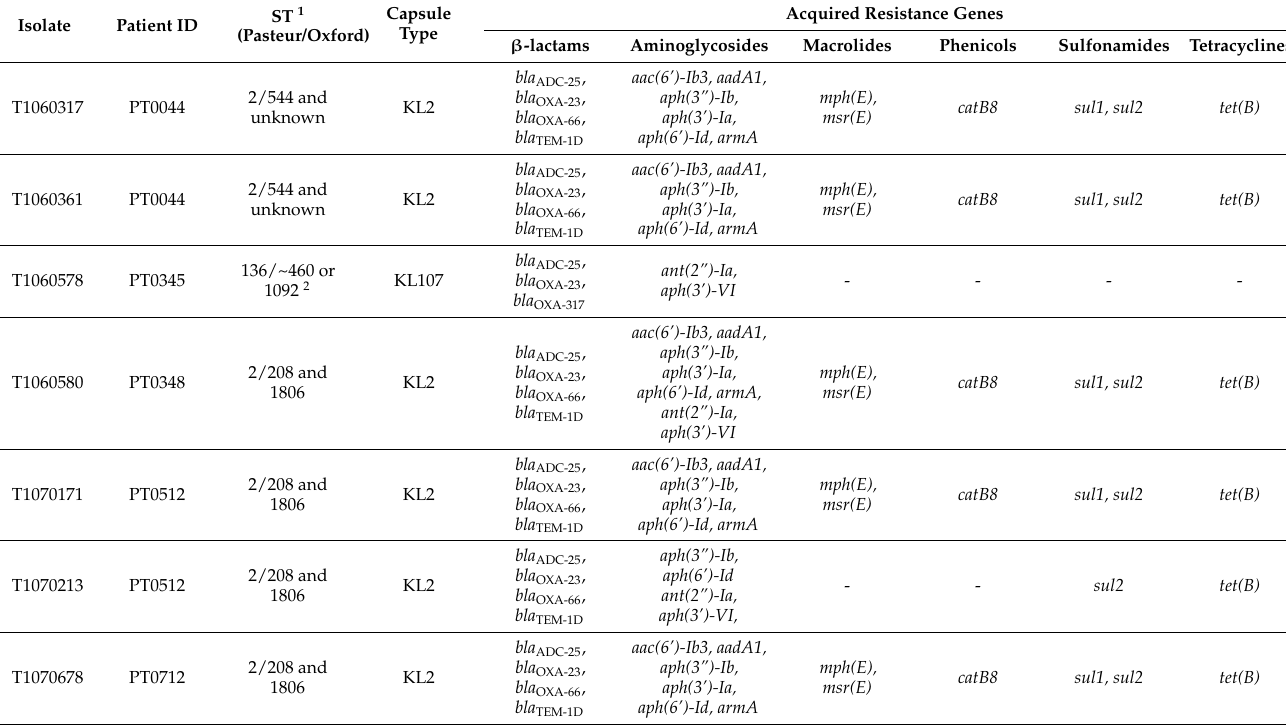
Table 2. Molecular characterizations and acquired antimicrobial resistance genes in the CCR-AB isolates.